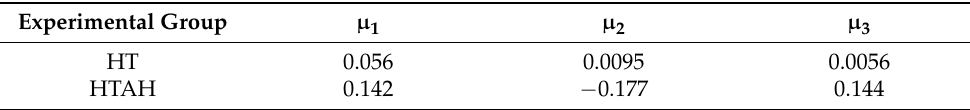
Table 6. µ i values in different environments ( i = 1 ∼ 3